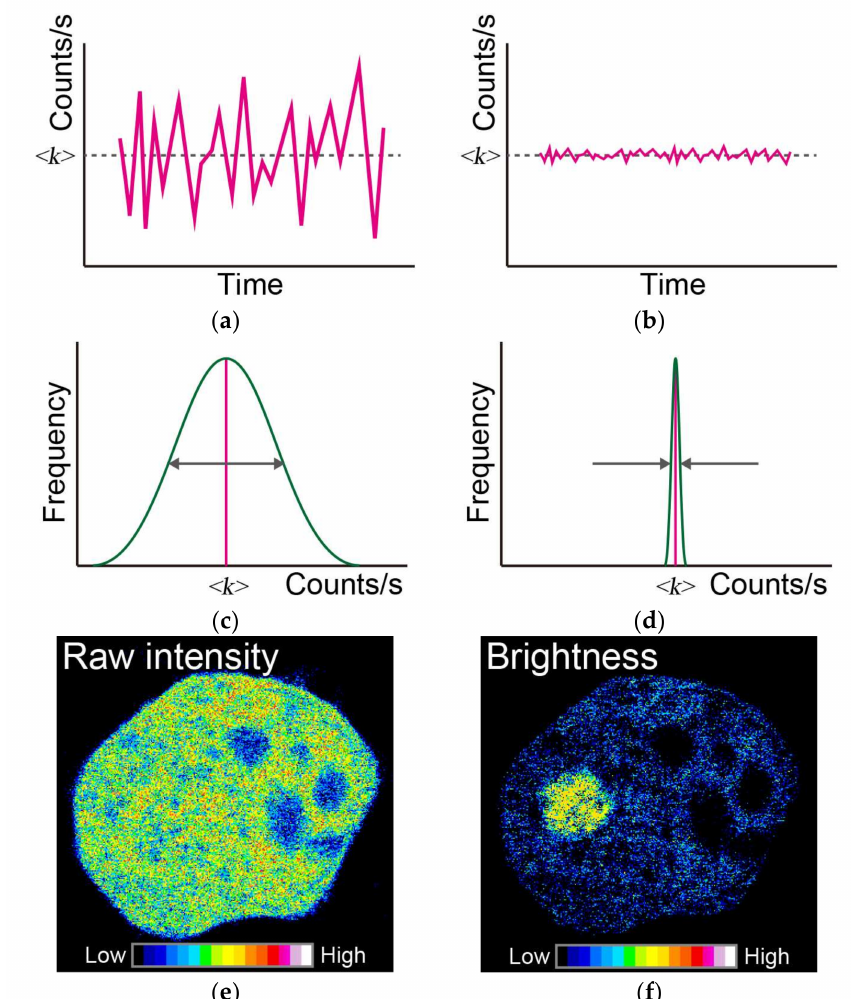
Figure 3. Principles of a typical number and brightness (N&B) analysis. Time-dependent fluctuation of fluorescence intensity in a pixel, such as in ( a , b ); in this case, the mean fluorescence intensity is the same as < k >, but the variance compared to the mean value is different (comparing between width of double arrow in ( c ) and width between arrows in ( d )). The distribution of variance is represented in ( c , d ). ( e ) Raw image of the recorded fluorescence intensity in a frame. ( f ) Typical image of the brightness of molecules simulated using the N&B approach. Pseudo-color indicates the strength of the raw fluorescence intensities and brightness of molecules (inset color scale in ( e , f )). White arrow in ( f ) indicates the position of